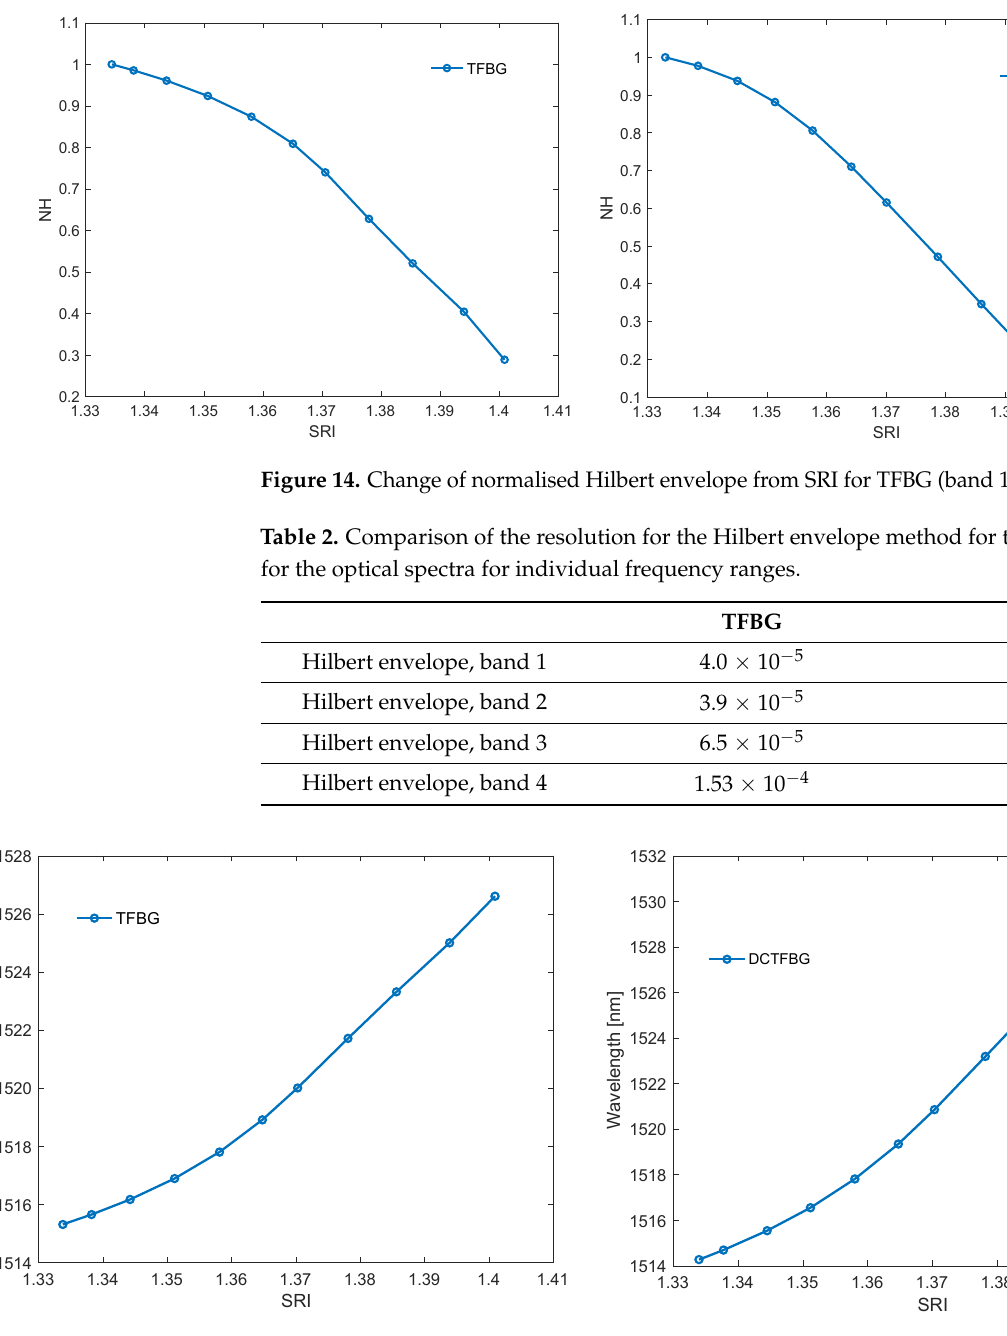
Figure 15. Change in the wavelength of the centre of gravity of the TFBG optical spectrum after band filtration for band 1 and for DCTFBG for band 2 filtration.